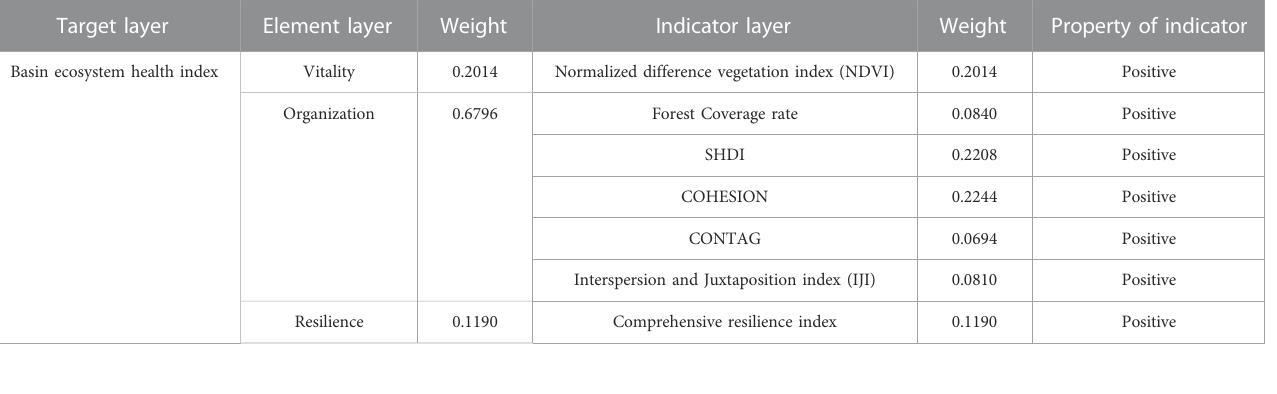
TABLE 4 Ecosystem health evaluation index and its weights in Dianchi Lake